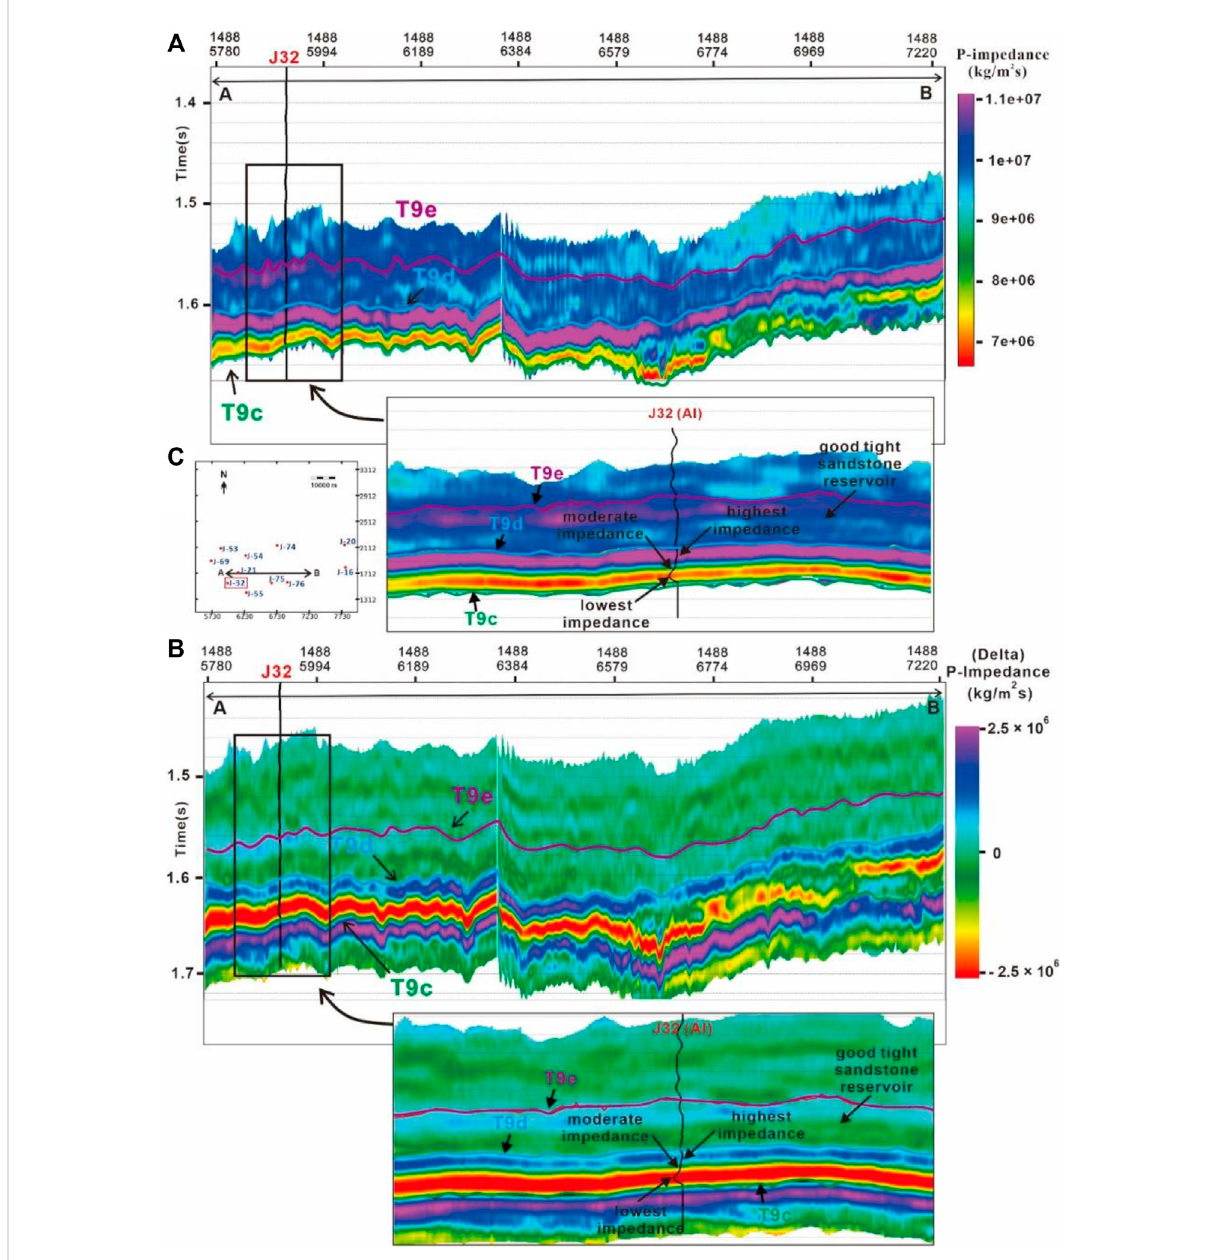
FIGURE 7 (A) Absolute AI broadband model along with the zoomed section on J32 location (B) . Bandlimited AI model along with a zoom section. An overlay well J32 on inverted AI models highlights the differences in impedance values. (C) A basemap showing the location of J32 and studied inline for inverted